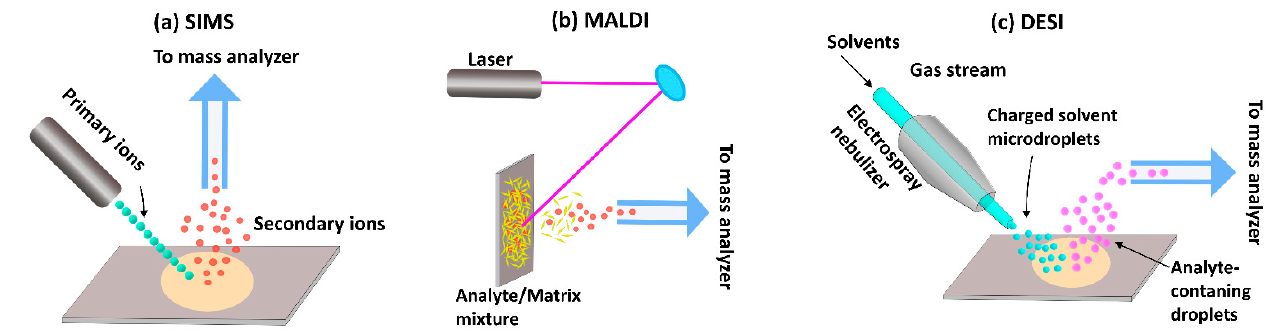
Figure 2. Ionization approaches used in MSI. ( a ) Secondary ion mass spectrometry (SIMS), ( b ) Matrix-assisted laser desorption/ionization mass spectrometry (MALDI-MS), ( c ) Desorption electrospray ionization mass spectrometry (DESI-MS).